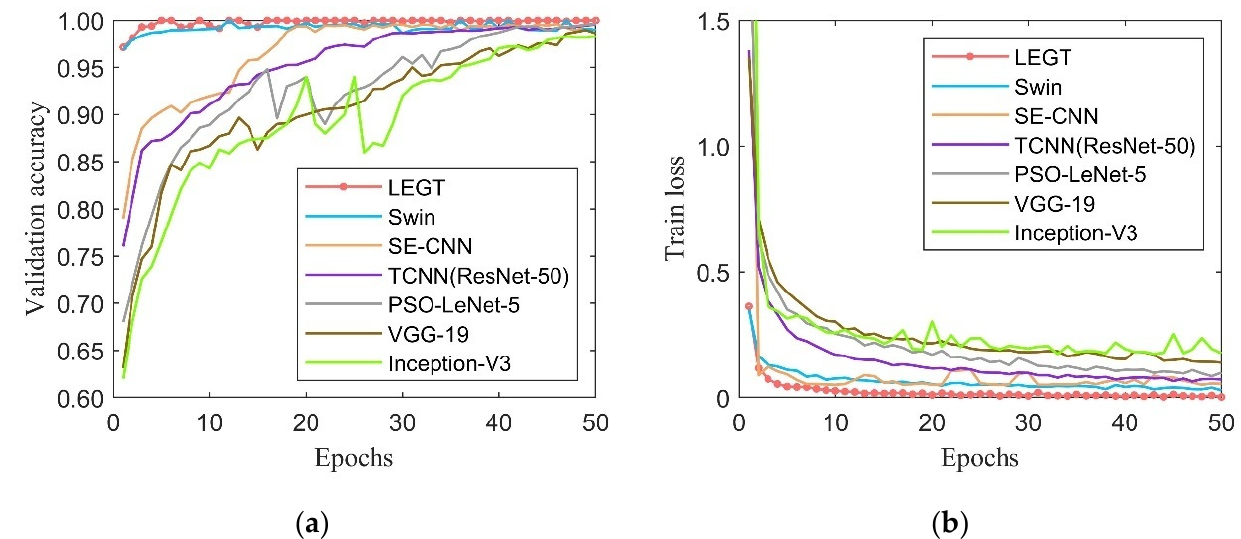
Figure 15. The training process among different models: ( a ) validation accuracy curves; ( b ) training loss curves.